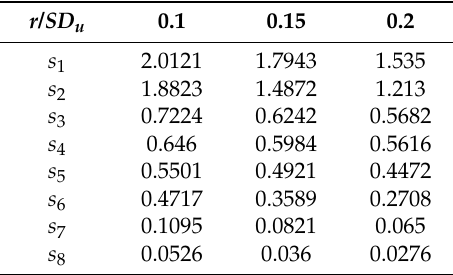
Table 1. SampEn of the